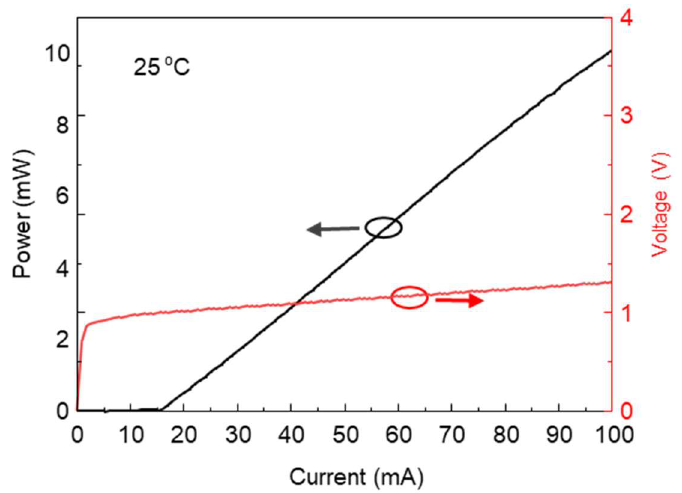
Figure 3. The light–current–voltage characteristics of the EML laser at 25 °C.